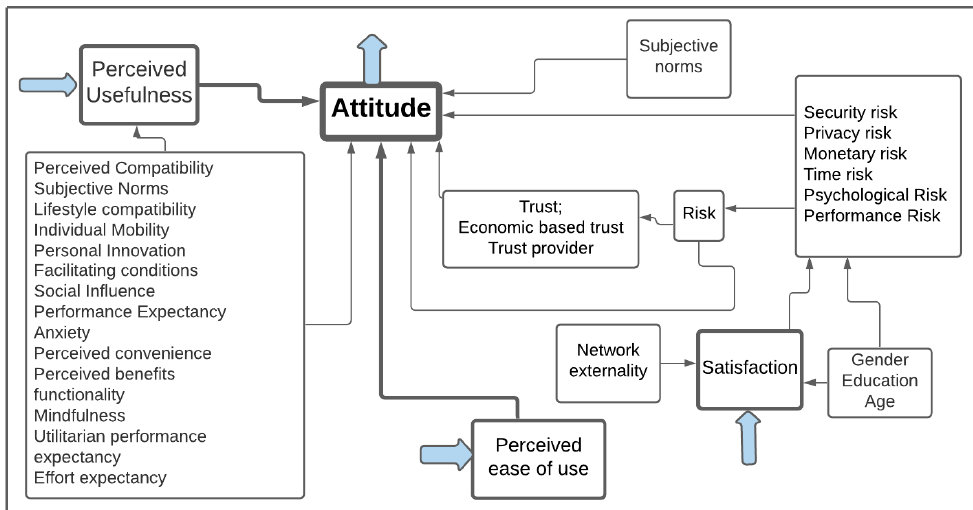
Figure A1. The attitude model of electronic payment.